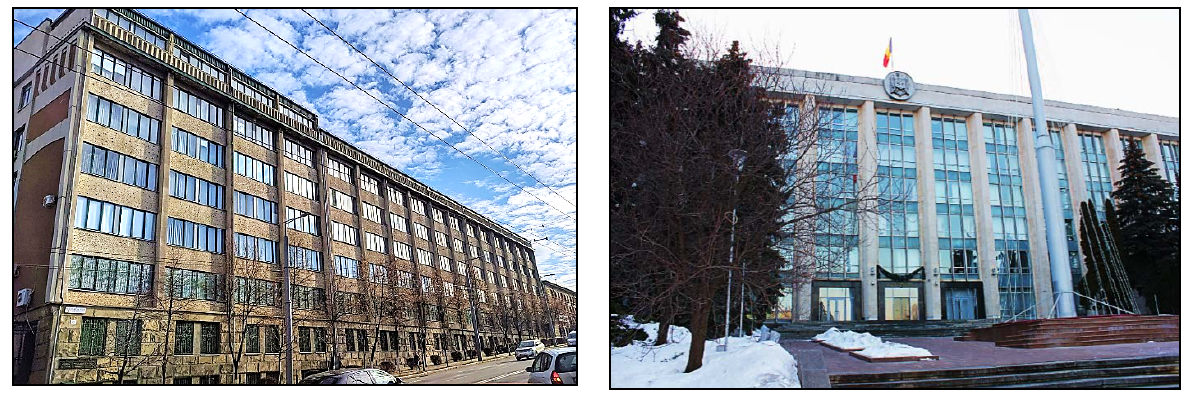
Figure 6. The ID Moldhyprostroy, 1967. Figure 7. The Government House,